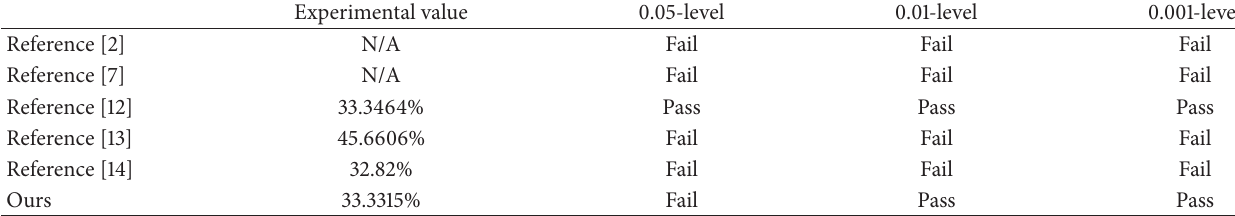
Table 6: UACI test for the different image encryption algorithms.